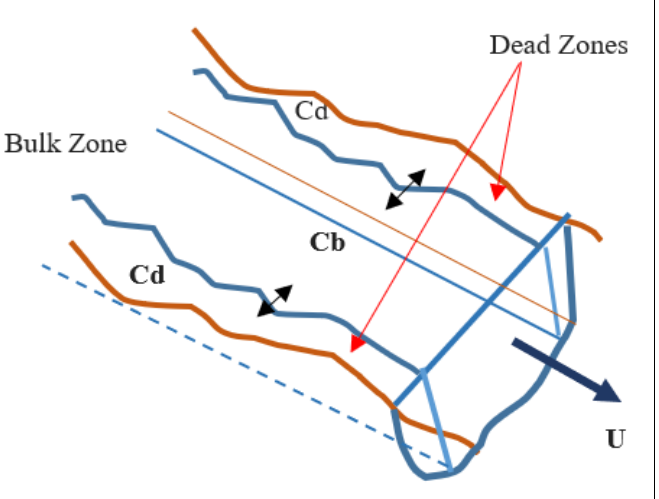
Figure 6: Geometric model of "Dead Zones". Source: Authors, (2023).